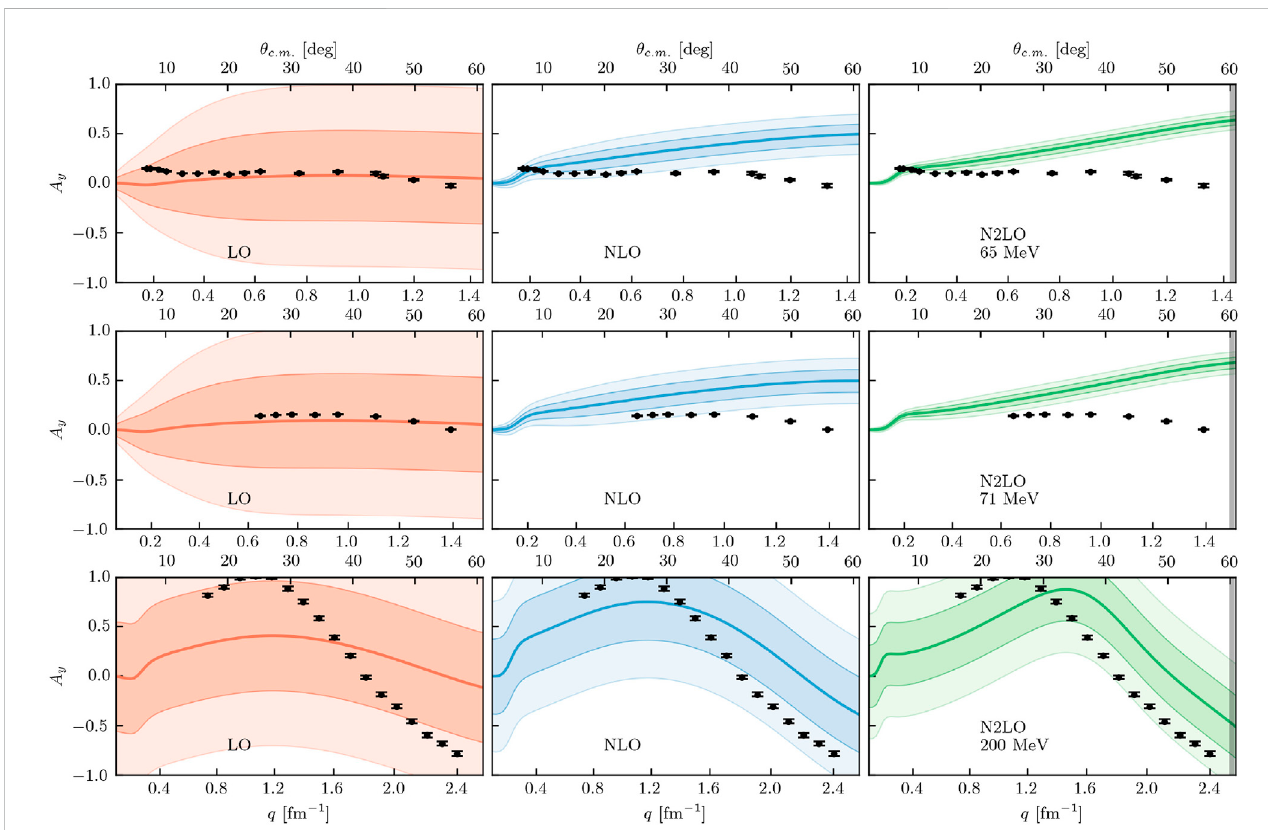
FIGURE 5 Analyzing power for proton scattering on 4 He at ( fi rst row) 65 MeV, (second row) 71 MeV, and (third row) 200 MeV) for LO (left column), NLO (middle column), and N2LO (right column) with corresponding 1 σ (darker bands) and 2 σ (lighter bands) error bands. Black dots are experimental data from Ref. [75] (65 MeV) [76], (71 MeV), and [78] (200